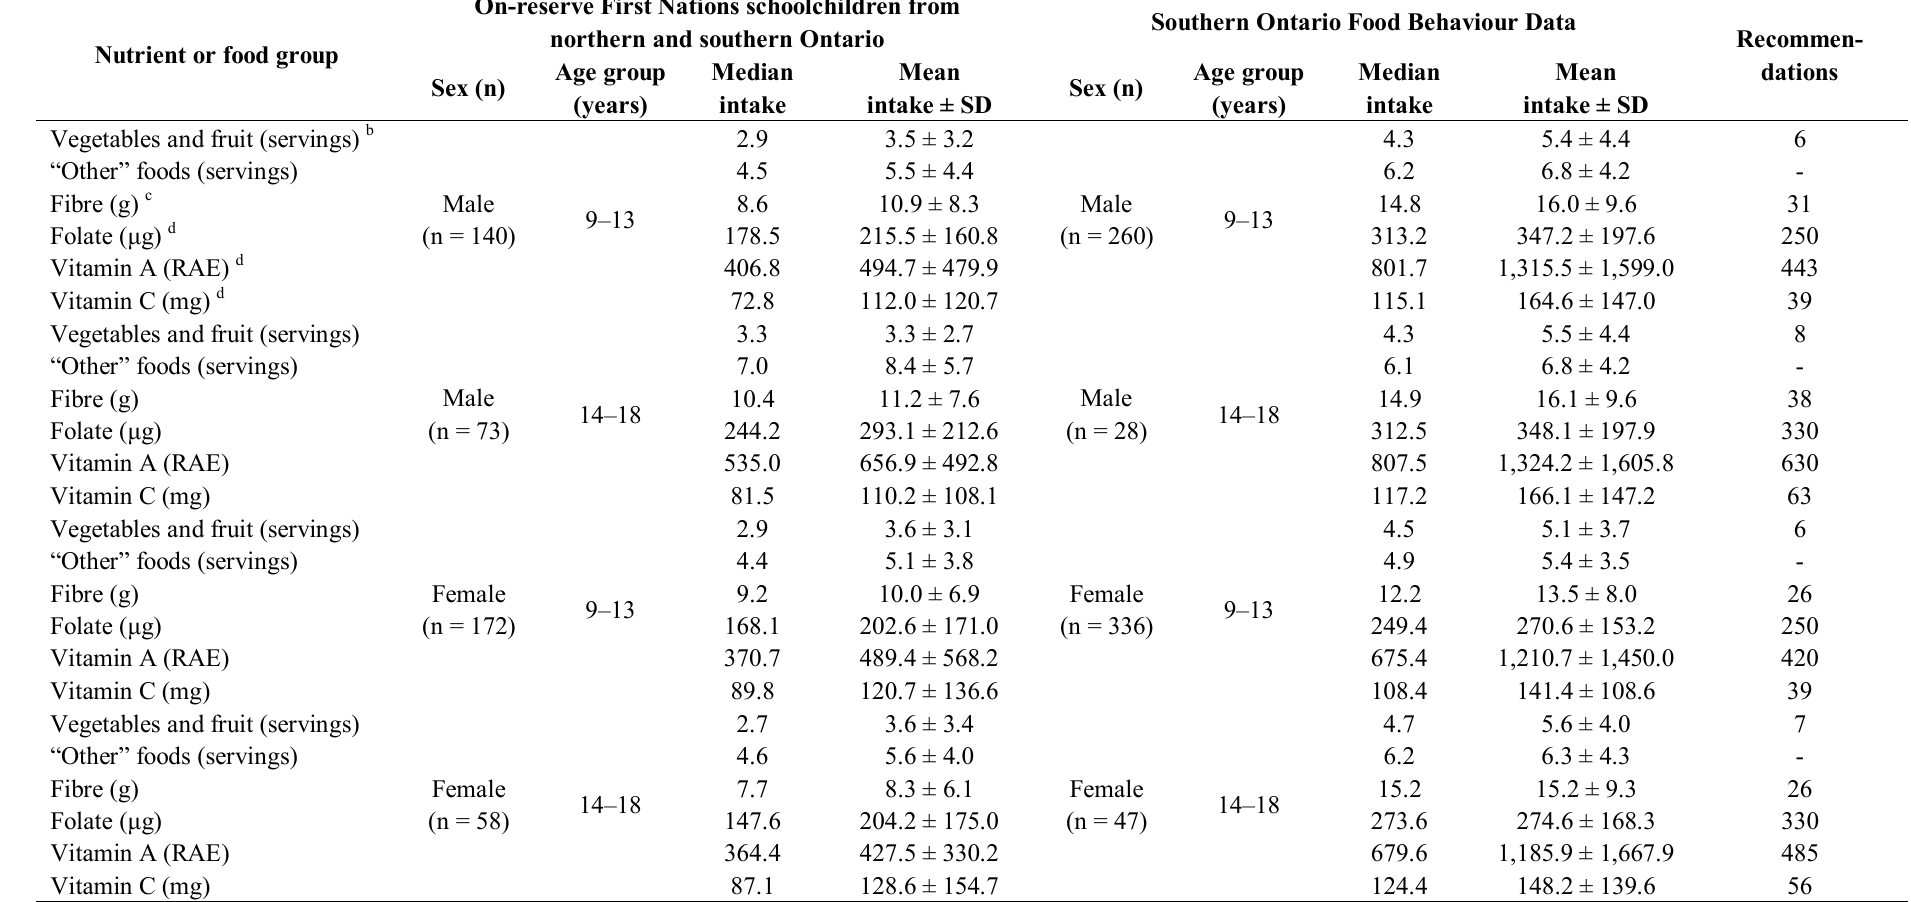
Table 4. Nutrient and food group intakes as compared to current dietary standards and Southern Ontario Food Behaviour data a